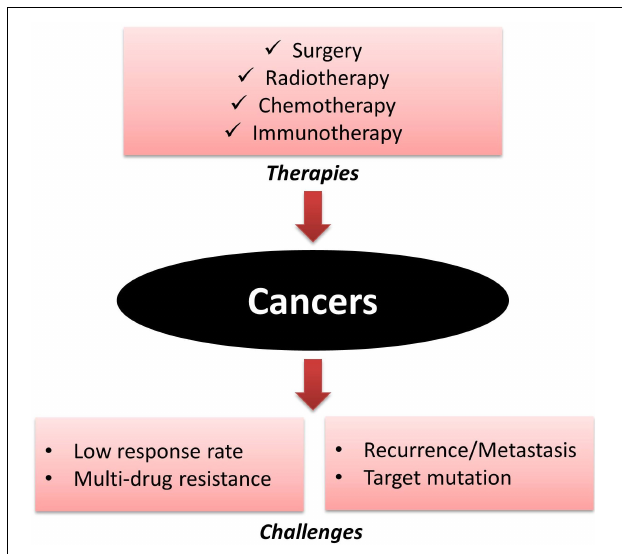
FIGURE 1 | Cancer treatment and critical